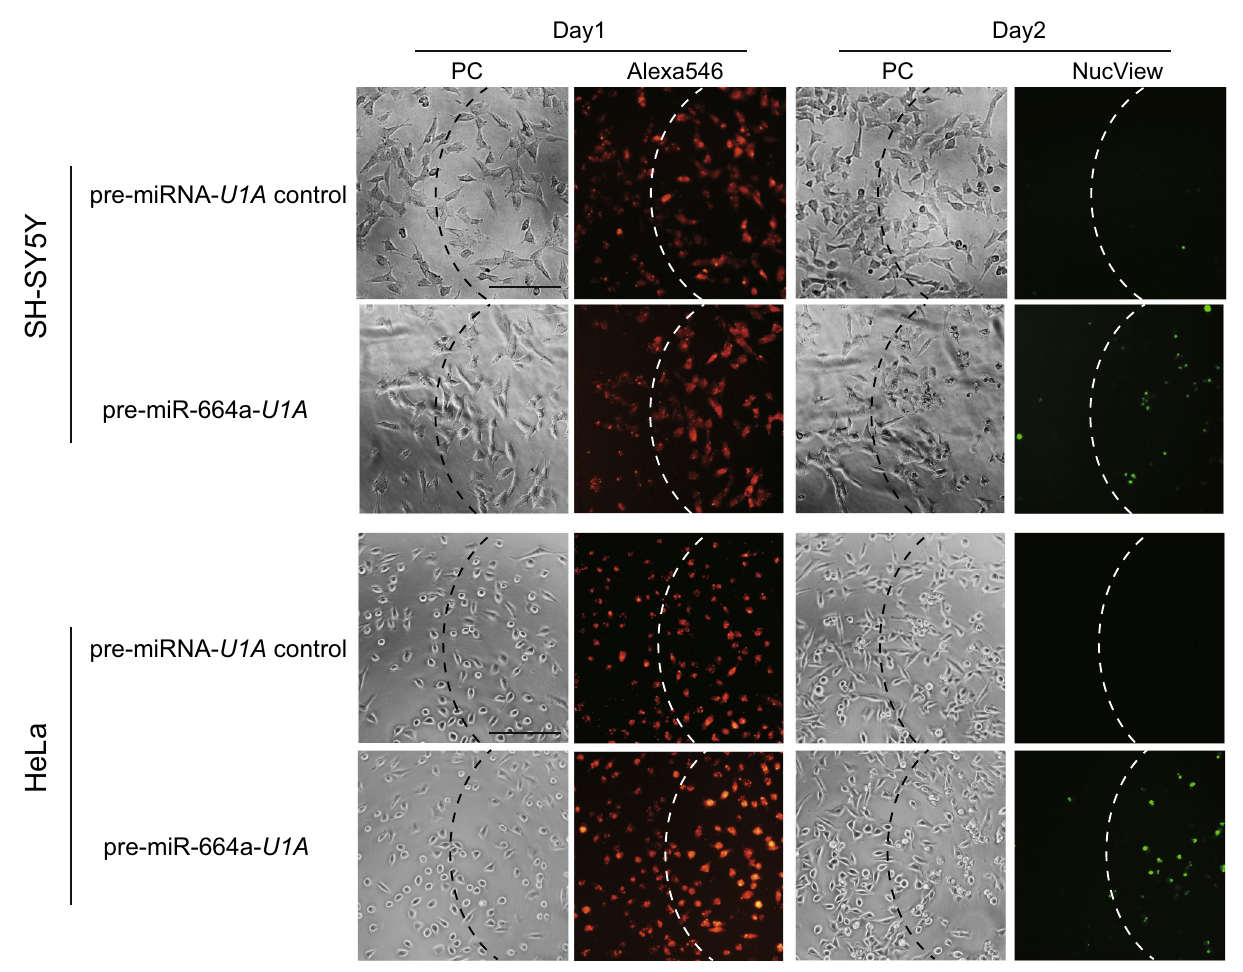
Figure 7. Region specific apoptosis of cells transfected with pre-miR-664a- U1A. The cells were treated with TatU1A-Alexa546 and pre-miRNA complexes. Then, the cells to the right of the dotted line were irradiated (Day 1). Phase contrast and TatU1A-Alexa546 fluorescence images were immediately obtained. Apoptotic cells were detected using NucView 488 caspase assay kits (Day 2). PC phase-contrast images. Scale bars indicate 100